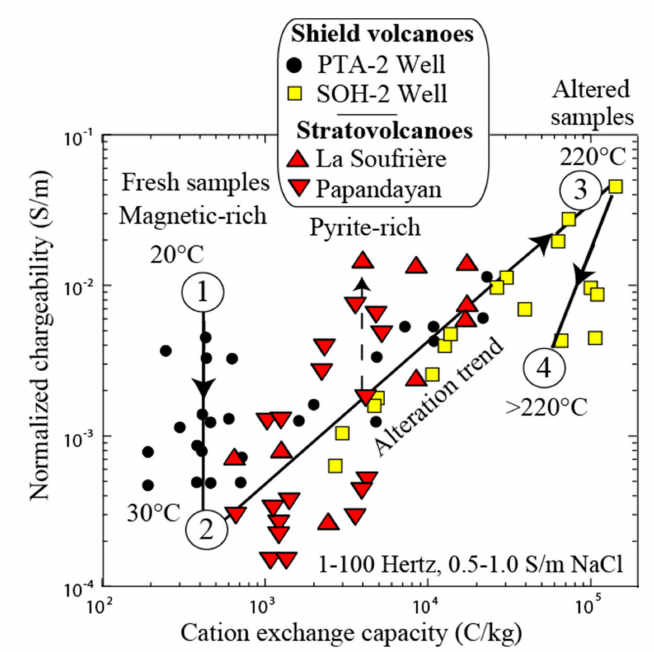
Figure 21. Geoelectrical alteration path. Stage (1) corresponds to fresh magnetic-rich samples. Stage (3) corresponding to smectite-rich strongly altered core samples. From stages (1) to (2) the magnetic content decreases with the depth of burial. In stage (2), magnetic has disappeared and the alteration starts with an increase of the content in smectite until a temperature of 220 ◦ C is reached at stage (3). Both porosity and CEC change along this trend. Above 220 ◦ C, smectite is progressively replaced by chlorite and mixed-layer clays with a lower CEC (see Figure 9b).